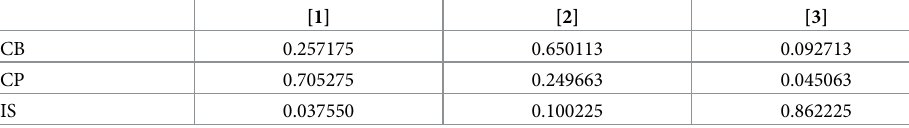
Table 8. Rank probabilities of fixation methods for pivot-shift